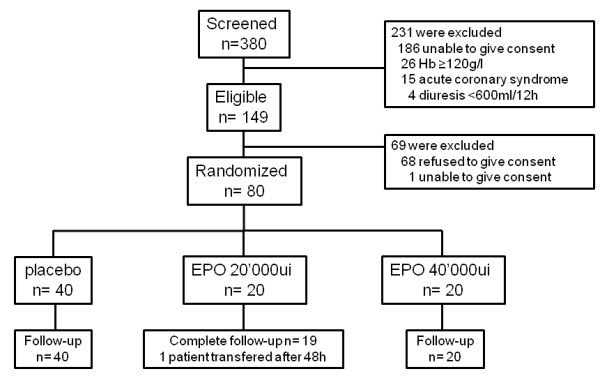
Study flow diagram.